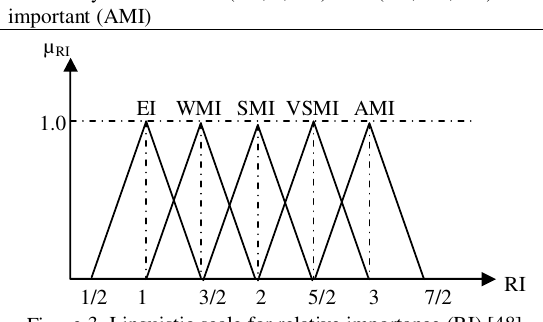
Figure 3. Linguistic scale for relative importance (RI) [48]